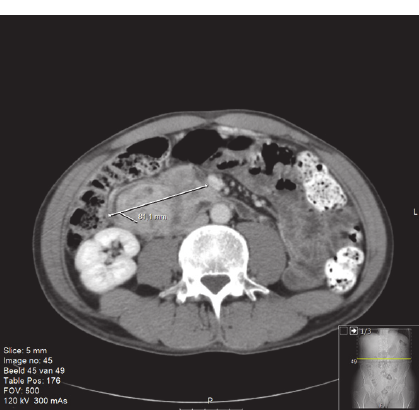
Figure 2: Coronal CT view showing a large mass near the proximal duodenum. Oral and IV contrast were